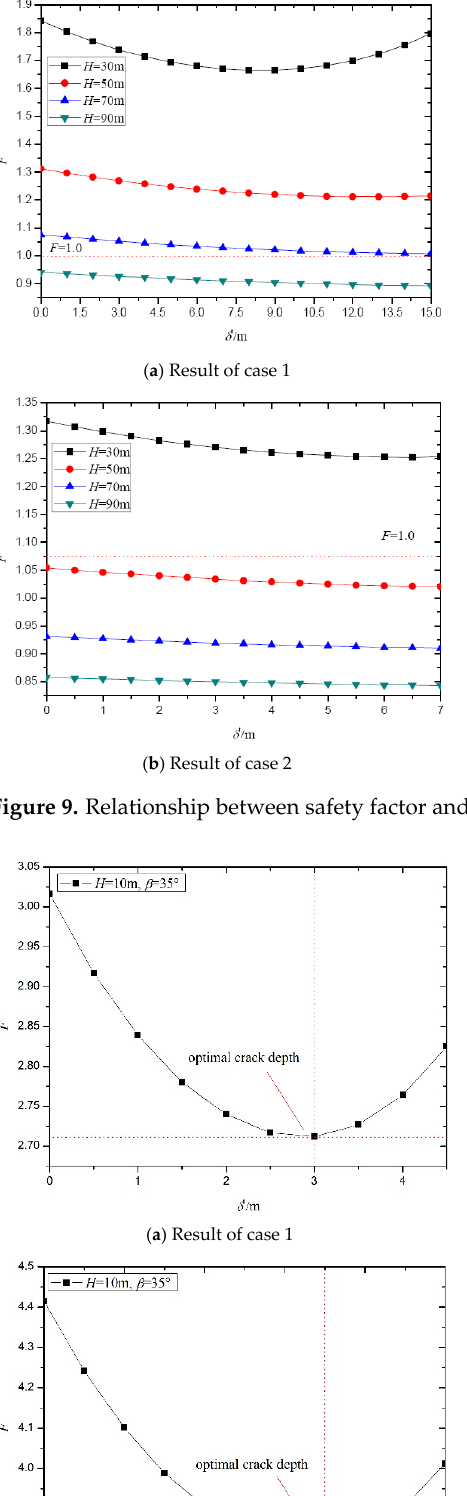
Figure 8. Relationship between safety factor and crack depth under different slope angle.